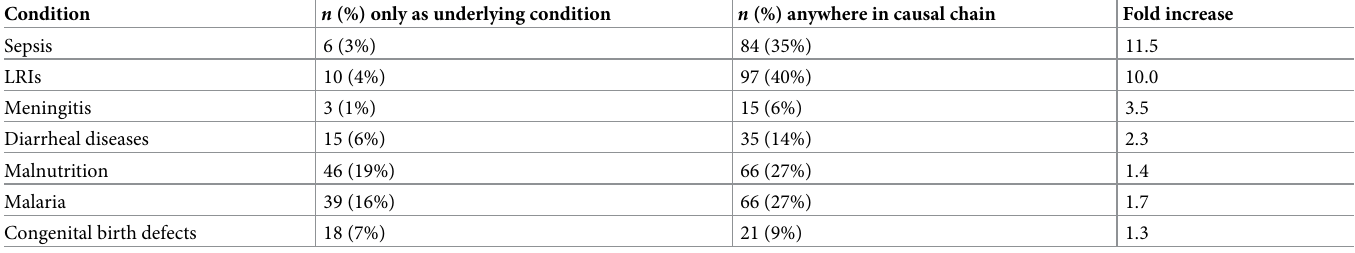
CoD, cause of death; LRI, lower respiratory infection.